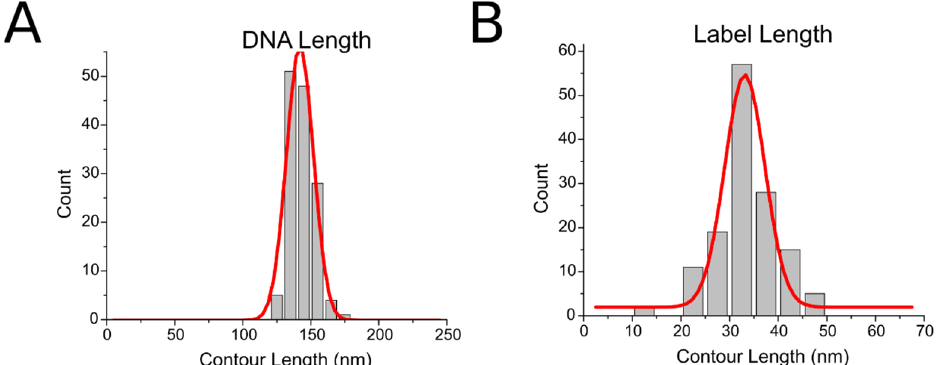
Figure 3. Contour length measurements of ( A ) DNA contour length and ( B ) Lengths of the arms. DNA length is 142 ± 10 nm (S.D.) and label length is 33 ± 4 nm (S.D.).